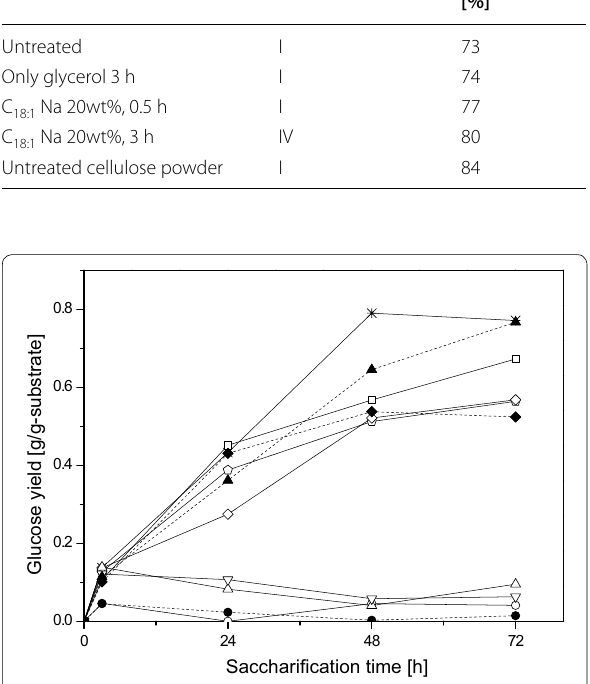
Fig. 6 Glucose yield by enzymatic saccharification from 1 g of Japanese cedar and oak powders treated with different